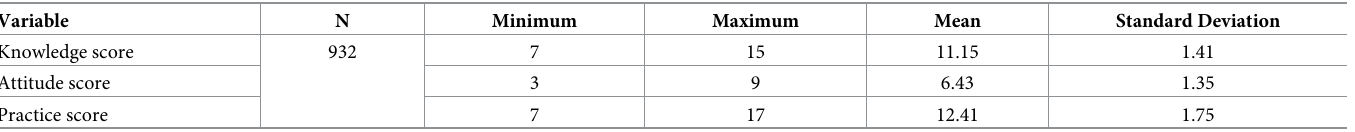
Table 1. Descriptive statistics of knowledge, attitude, and practice